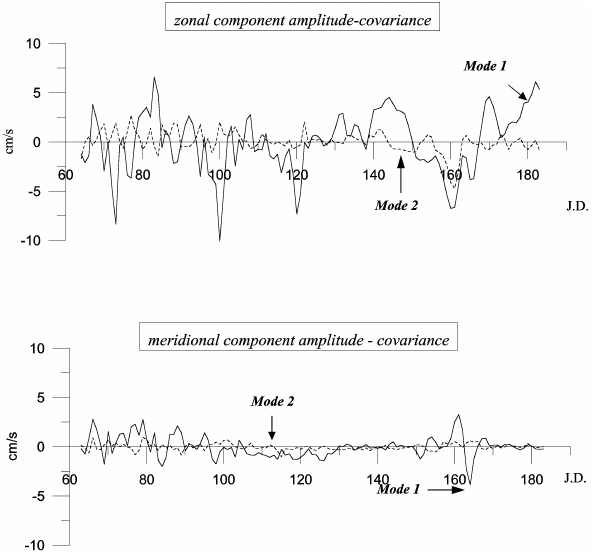
Fig. 12. Zonal and meridional component amplitude time series for the second period (06 September 2000 – 01 March 2001; J.D. 250 – J.D.